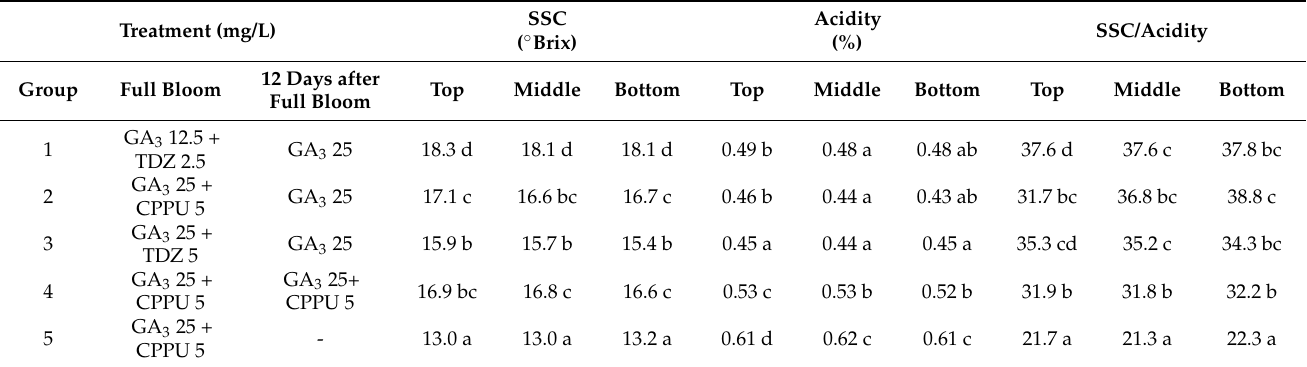
Table 3. Effects of gibberellic acid 3 (GA 3 ), thidiazuron (TDZ), and forchlorfenuron (CPPU) applica- tion on the fruit sweetness (SSC) and acidity of the seedless ‘Shine Muscat’ grape at